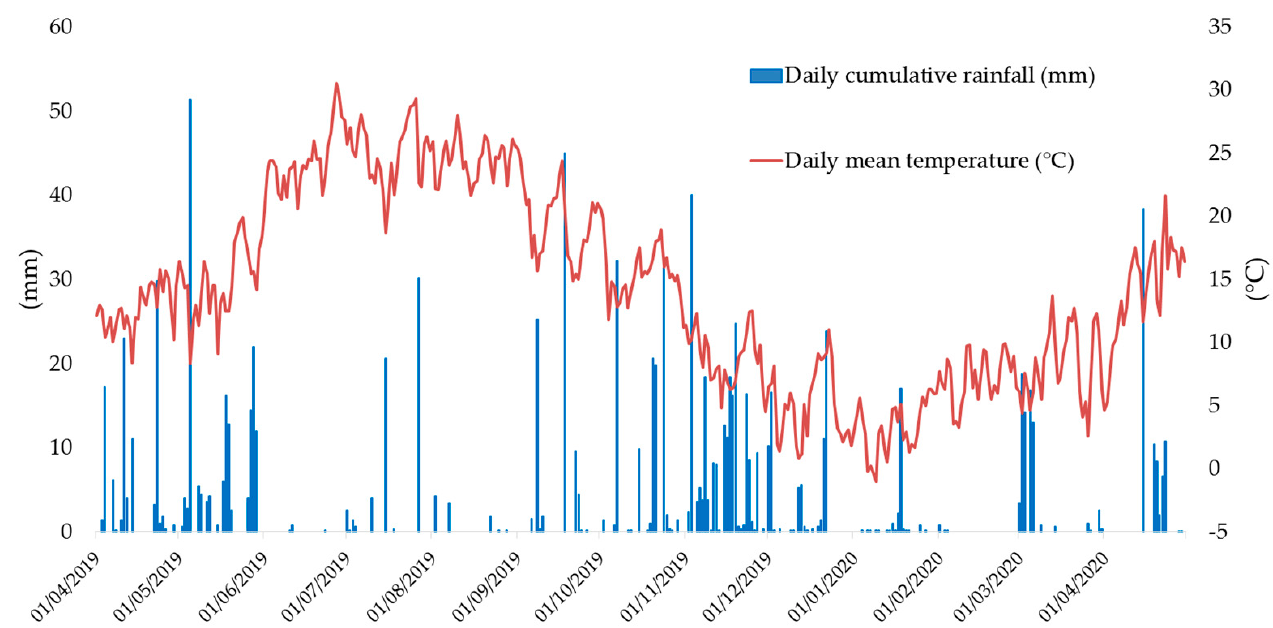
Figure 1. Daily rainfall (columns) and air temperature (line) during the field experiment (April 2019–April 2020).